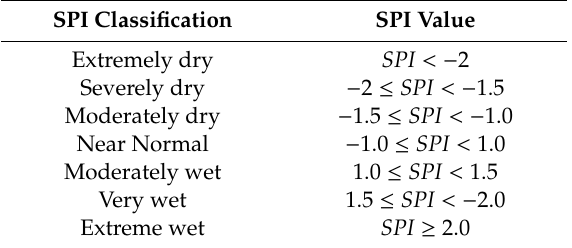
Table 1. Dry / wet categories defined by [8]. SPI: Standardized Precipitation